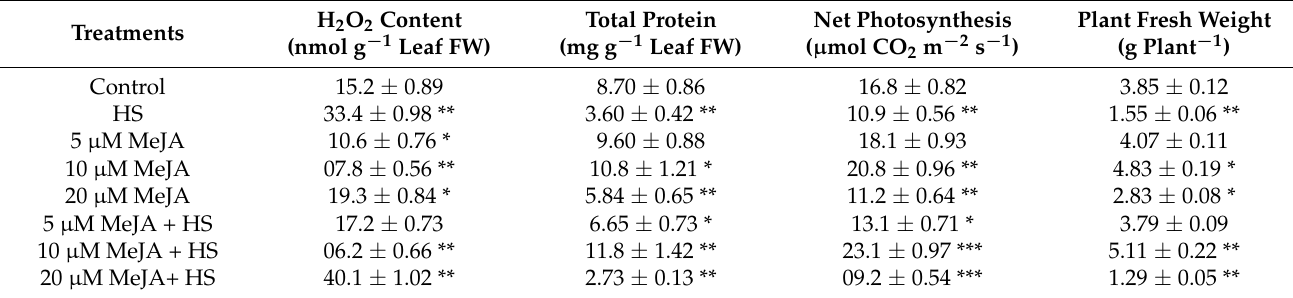
Table 2. Content of H 2 O 2 and total protein, net photosynthesis, and plant fresh weight of wheat leaves 30 DAS. Plants were treated with MeJA (5, 10, and 20 µ M) at 42 ◦ C (heat stress) or 25 ◦ C (no stress). Data are presented as mean ± SE ( n = 4). Significantly different values between control and treatments are marked with an asterisk (* p < 0.05, ** p < 0.01, *** p < 0.001), determined by Tukey’s test. DAS, days after sowing; FW, fresh weight; HS, heat stress; H 2 O 2 , hydrogen peroxide; MeJA, methyl jasmonate.